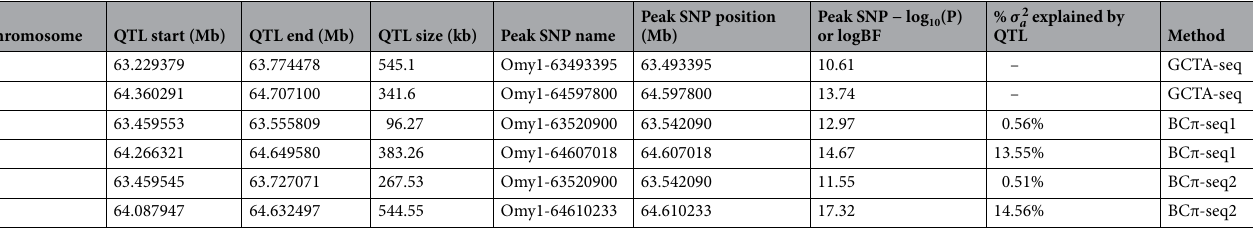
Table 5. Summary of the characteristics of the two QTLs associated with maleness in XX-rainbow trout detected using GCTA-seq and BCπ-seq methods. For GCTA-seq, the start and stop positions of the first QTL correspond to a CI estimated with a drop-off method and the start and stop positions of the second QTL correspond to the credibility interval estimated as the union of confidence intervals of four QTLs. The BCπ- seq1 and BCπ-seq2 correspond to the same analysis run with two different seeds for MCMC initialization. Significance of peak SNP is calculated as the –log 10 (P-value) for GCTA-seq, and as logBF estimated as twice the natural logarithm of Bayes Factor for BCπ-seq. % σ 2 a : proportion of total genetic variance explained by the QTL calculated as the sum of the variance estimated by BCπ-seq analyses of all SNPs within the QTL credibility